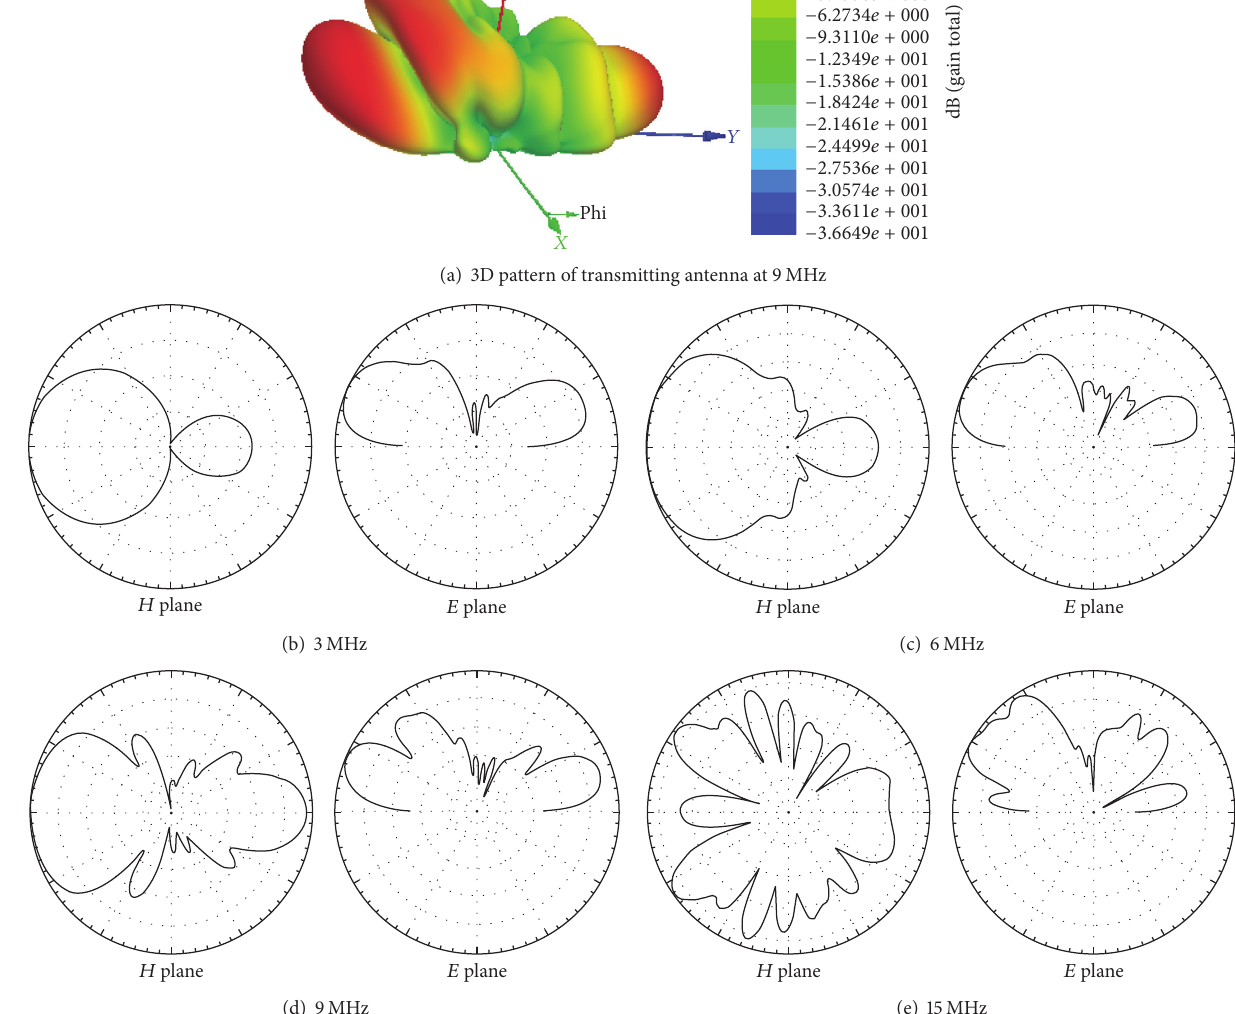
Figure 5: Pattern of log periodic dipole transmitting antenna. The maximum length is 12.5 m. The minimum length is 2.5 m. The copper ground screen is 100m 2 . The diameter of grid is 10